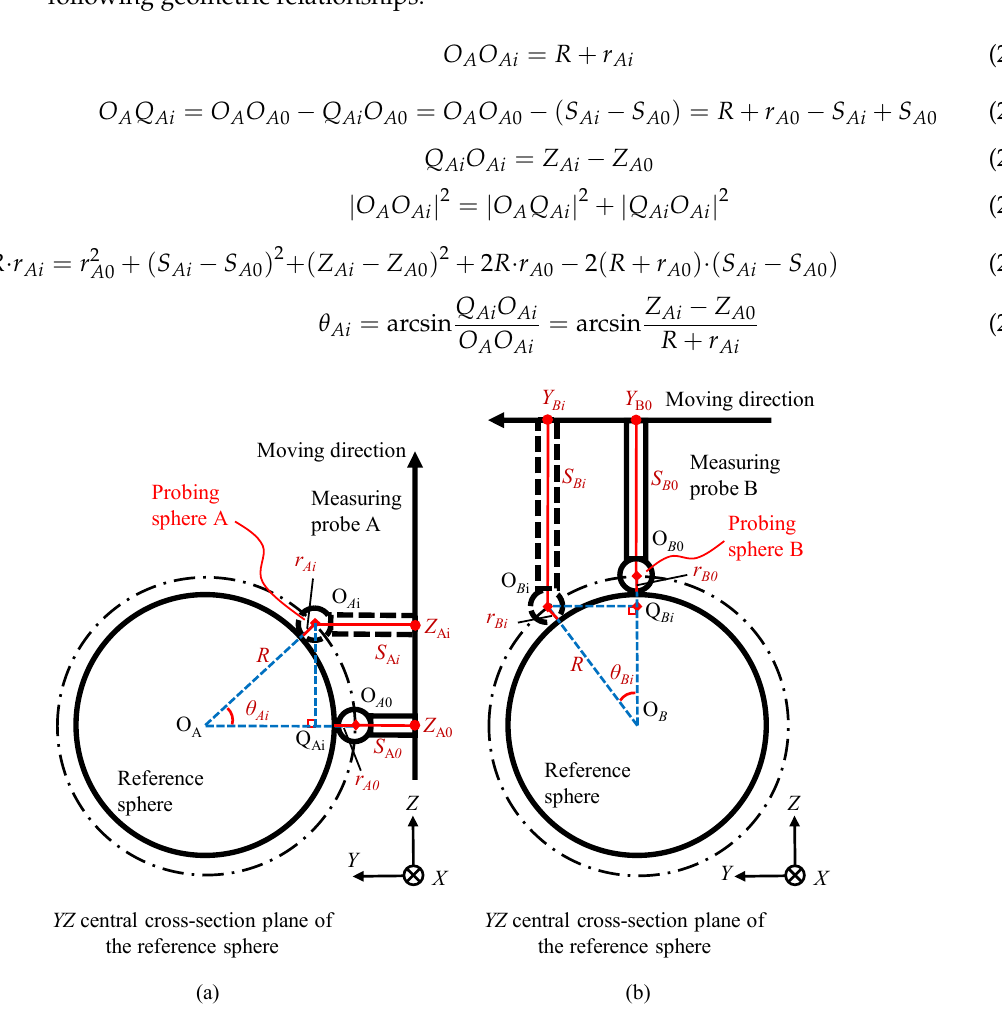
Figure 7. Schematic of sphere roundness calibration of the measuring probes. ( a ) Schematic of measuring sphere roundness calibration for lateral probe (probe A); ( b ) schematic of measuring sphere roundness calibration for axial probe (probe B).